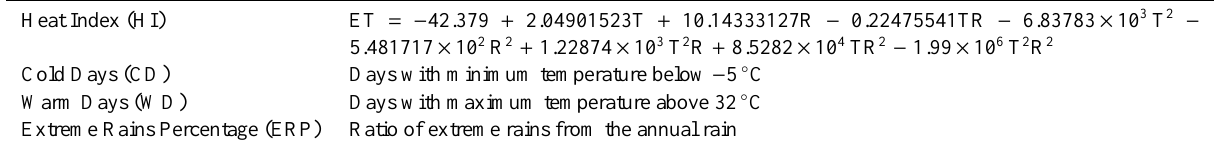
Table 1. Indices used to identify extreme climatic events.